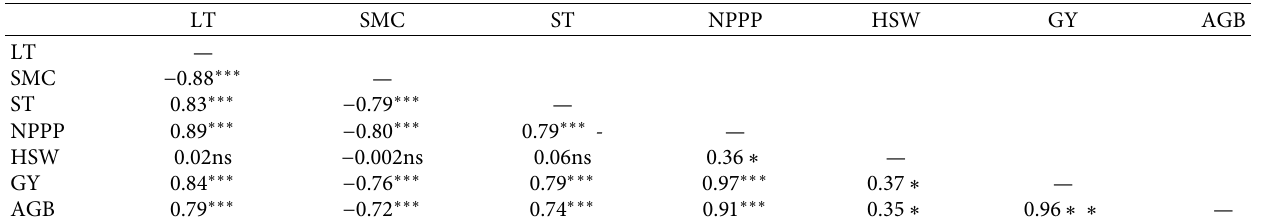
Table 5: Linear correlation among microclimate, yield, and yield components of common